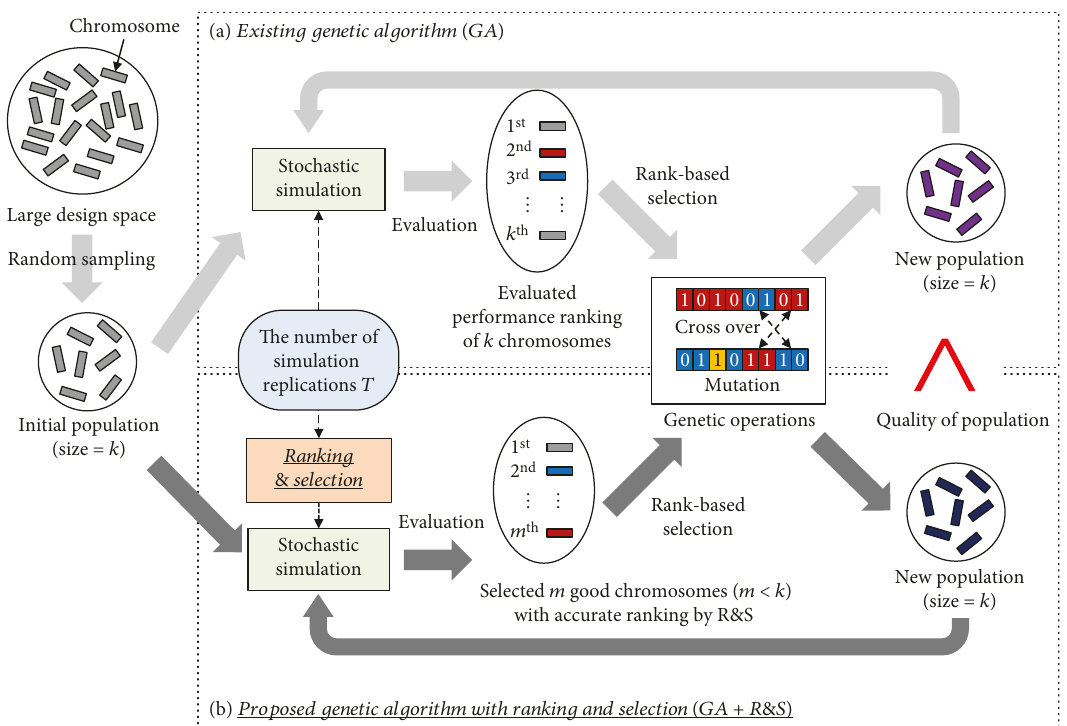
Figure 8: Procedures of the existing GA and the proposed GA with